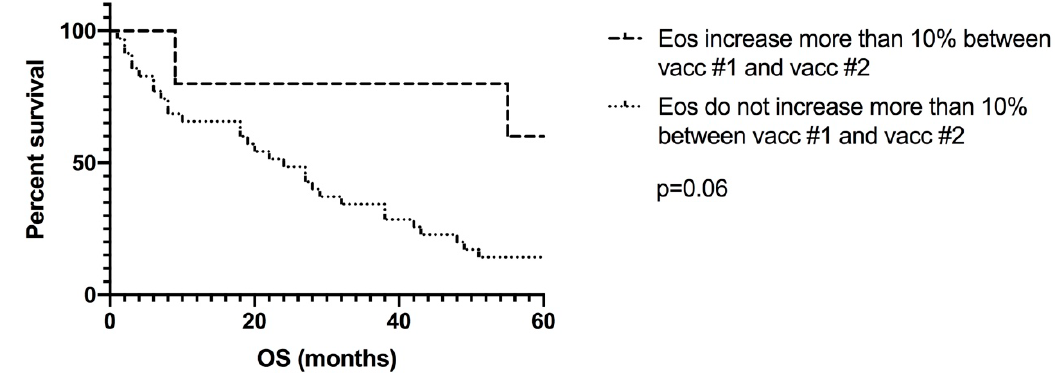
Figure 4. Per-protocol analysis to evaluate the early change in eosinophil count between the first and the second DC vaccines. In 12% of the patients ( n = 5), an immediate increase in eosinophil count of at least 10 percentage points could be detected after the first vaccine, which appeared to correlate with survival (65 vs. 24 months; p = 0.06). DC: dendritic cells; Eos: eosinophilia; OS: overall survival.